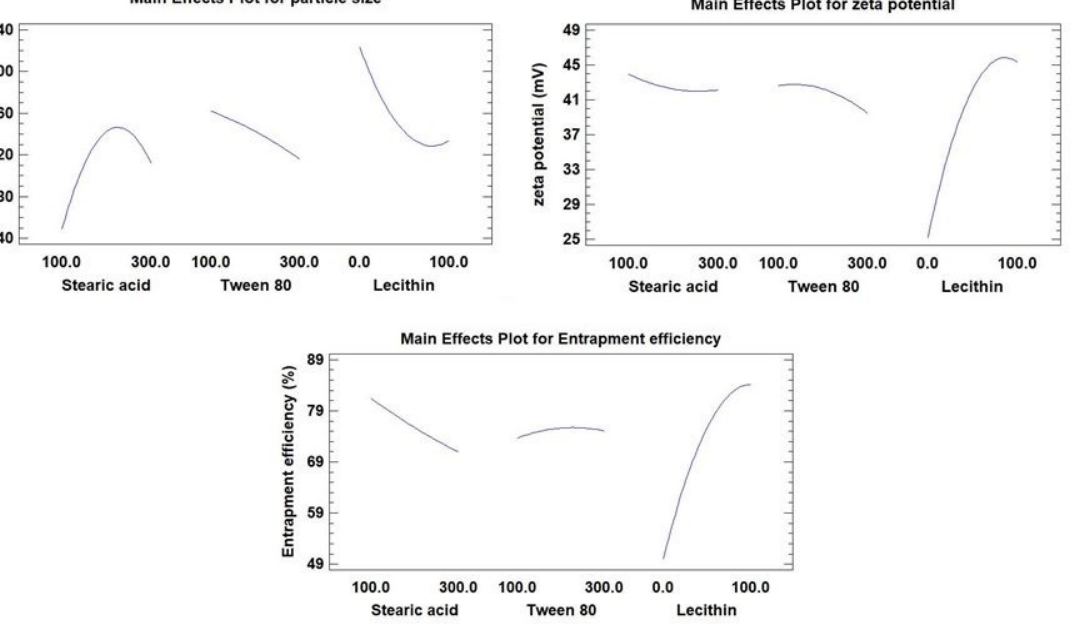
Figure 1. Main effect plots showing the effects of the investigated factors on all responses (Y 1 –Y 3 ).